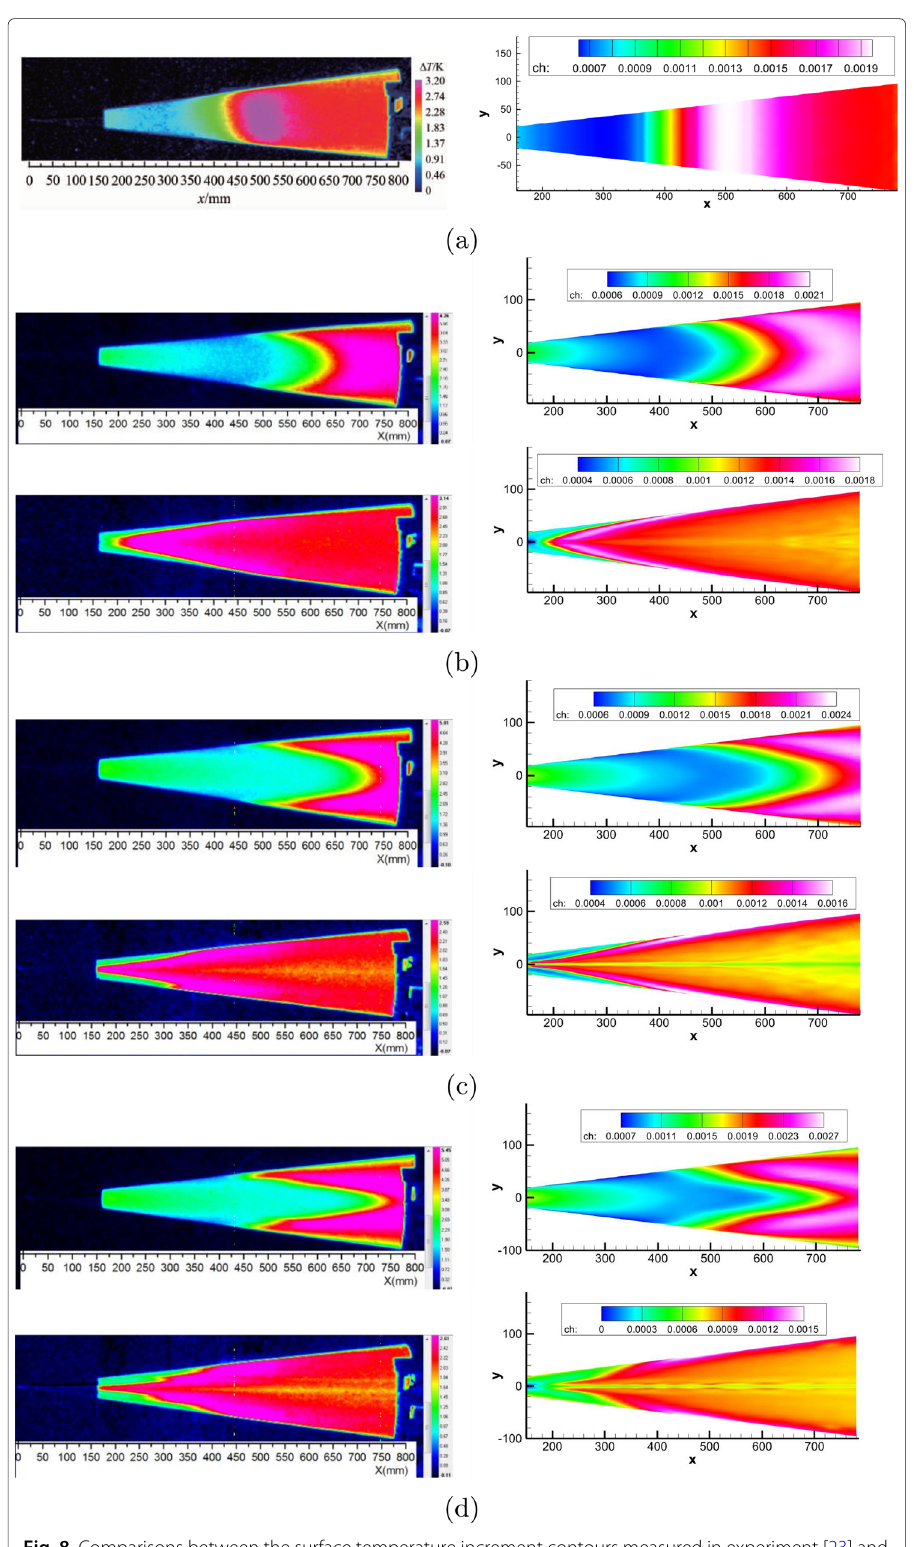
Fig. 8 Comparisons between the surface temperature increment contours measured in experiment [23] and the St contours computed by the SED-SL model for a the CARDC-0 case, and the windward and leeward surfaces of b the CARDC-2 case, c the CARDC-4 case, and d the CARDC-6